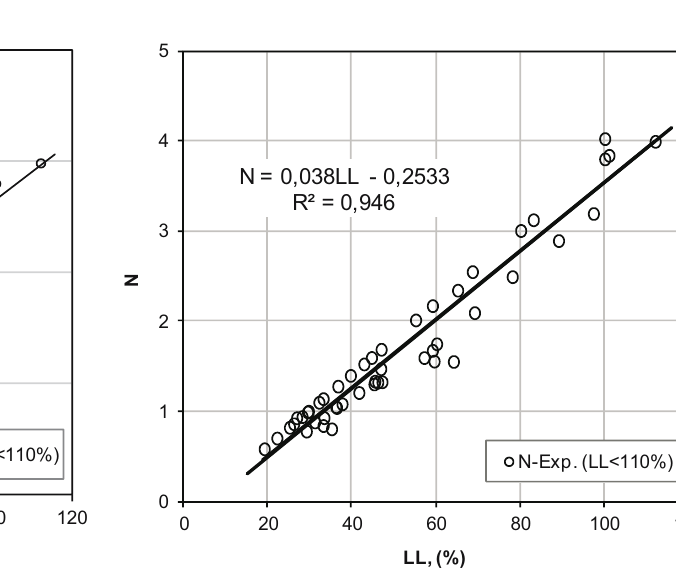
Figure 3: Best - fi t relationship of N/G versus LL < 110%.